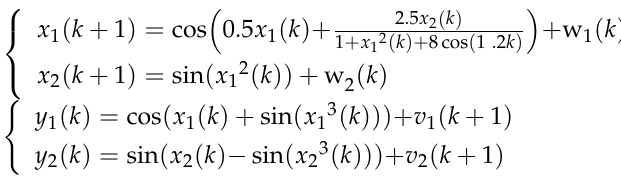
( d ) Figure 7. ( a , b ) Set parameters: